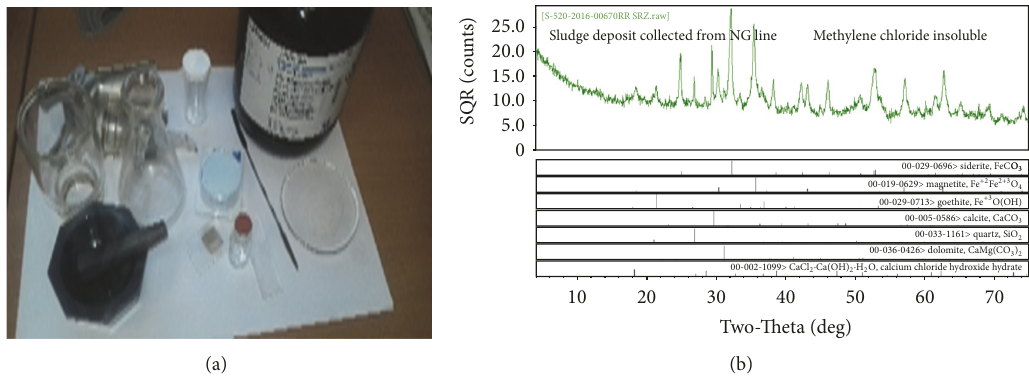
Figure 2: (a) The schematics of dichloromethane, filtration assembly, mortar pestle, filter paper, beaker, spatula, and container. (b) Phase identification results of sludge deposit collected from the NG line, where the methylene chloride was